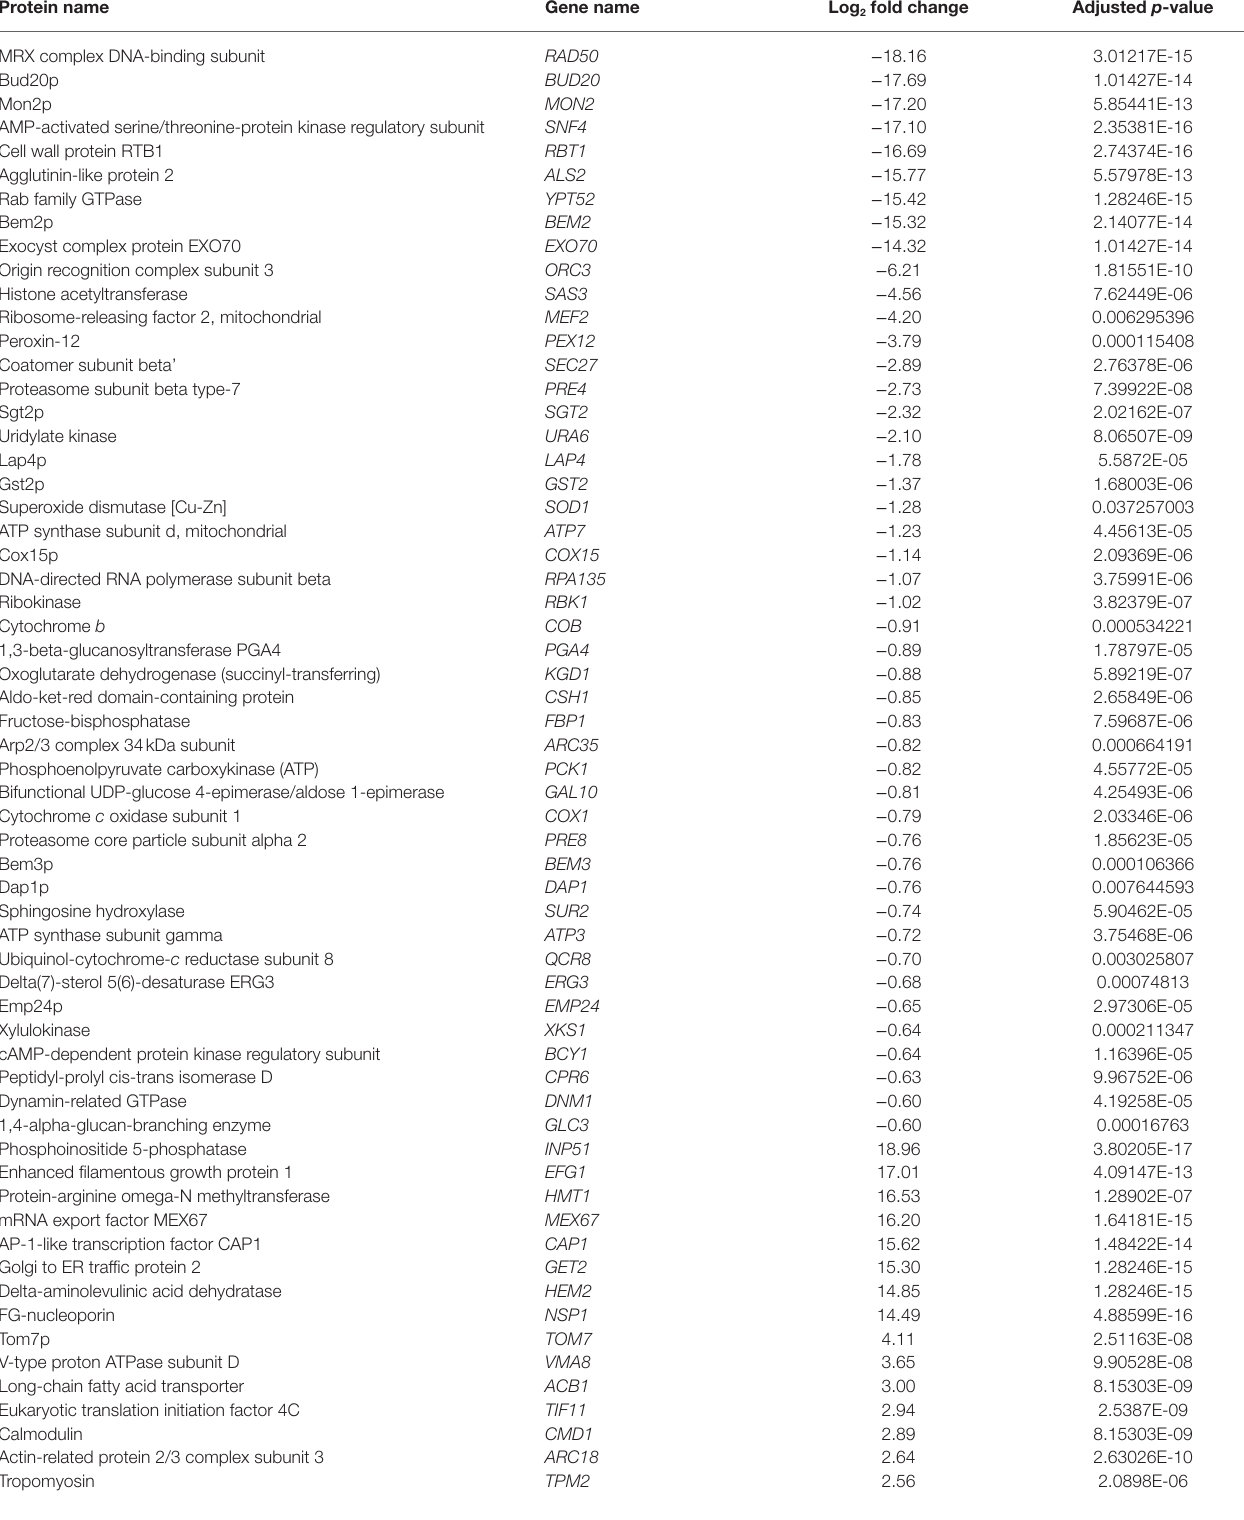
TABLE 2 | List of protein expression in Candida albicans in β -citronellol treatment condition identified using